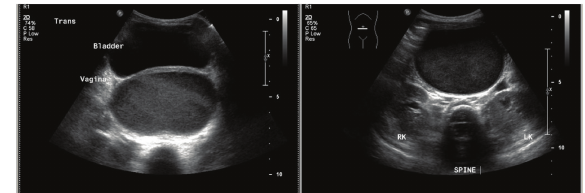
Figure 1: Pelvic ultrasound of Neonate A showing fluid collection in both bladder and vagina.